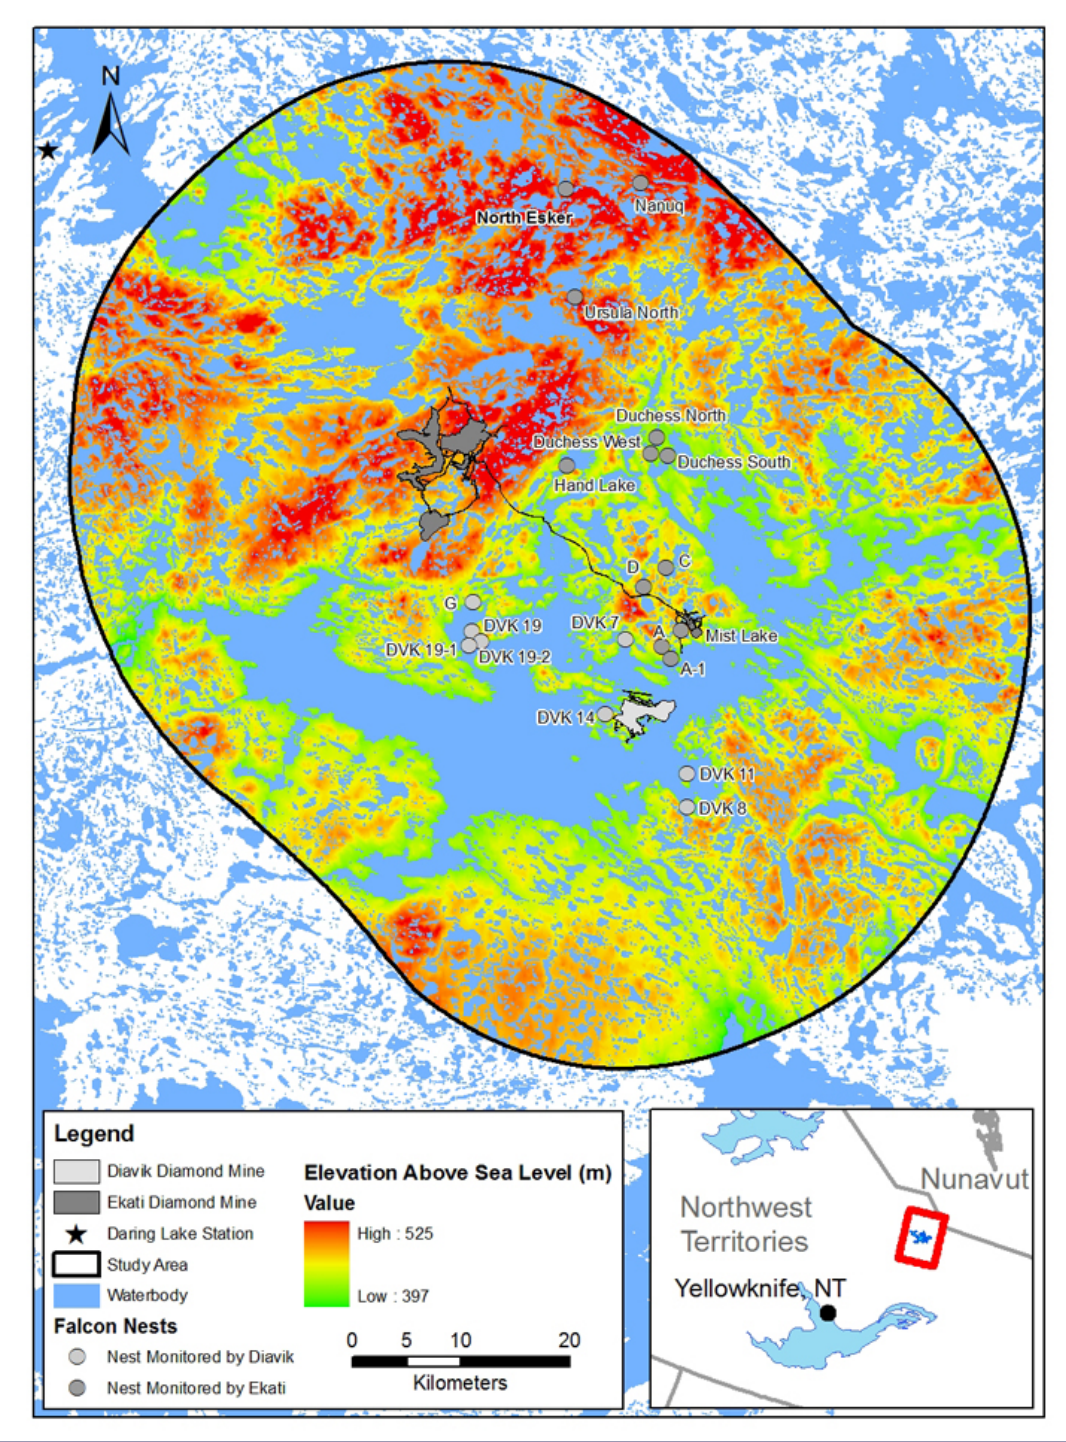
Fig. 1 . Location of raptor nest sites monitored in the Lac de Gras study area, Northwest Territories, Canada from 1998 to